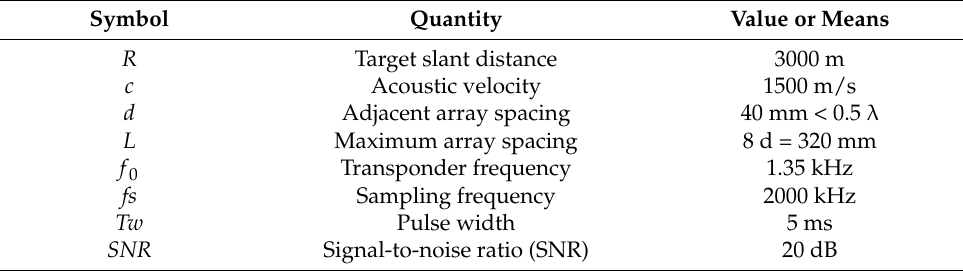
Table 1. Simulation conditions and parameters settings. Symbol Quantity Value or Means R Target slant distance 3000 m c Acoustic velocity 1500 m/s d Adjacent array spacing 40 mm < 0.5 λ Maximum array